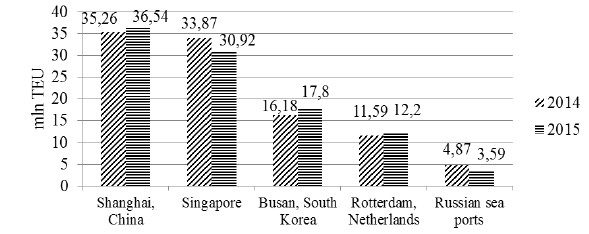
Figure 2: Container volume dynamics of major seaport in the world in 2014–2015.